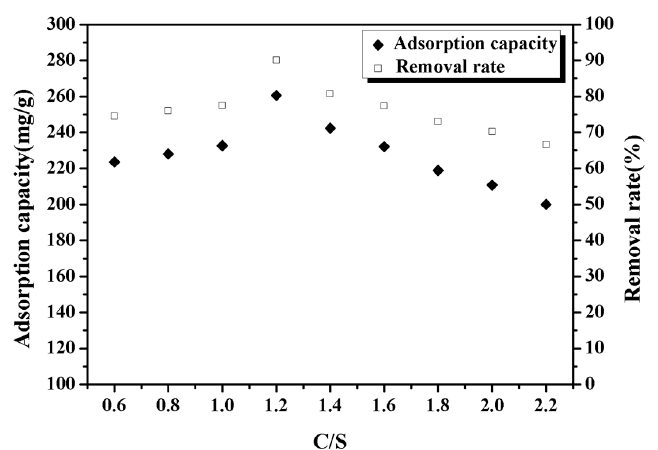
Figure 3. Adsorption of lead ions using CSH with different calcium silicon ratio .